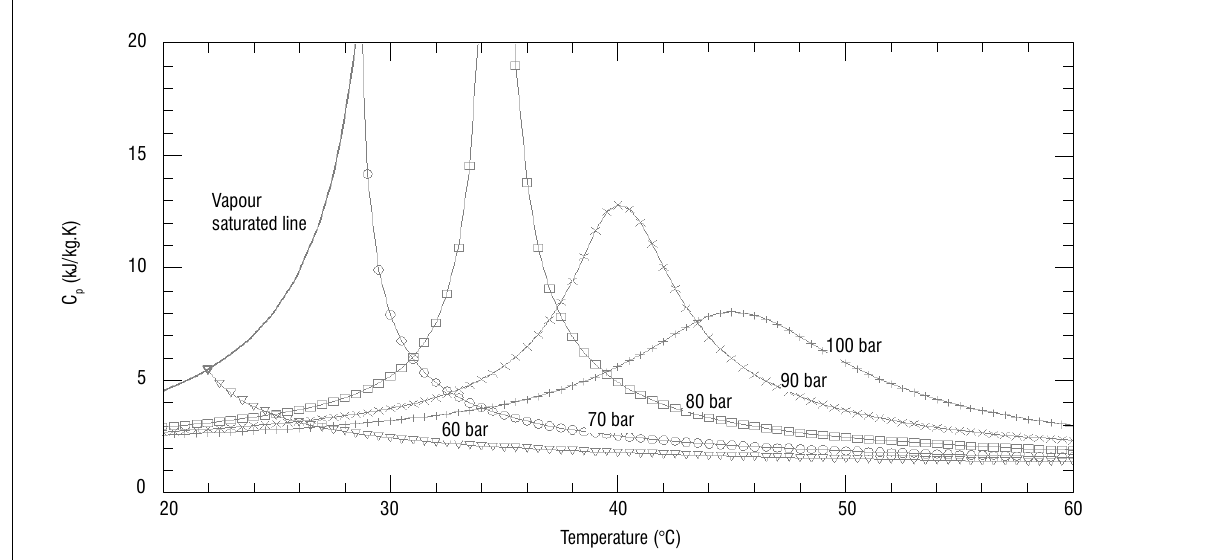
Figure 3: Variation of specific heat with